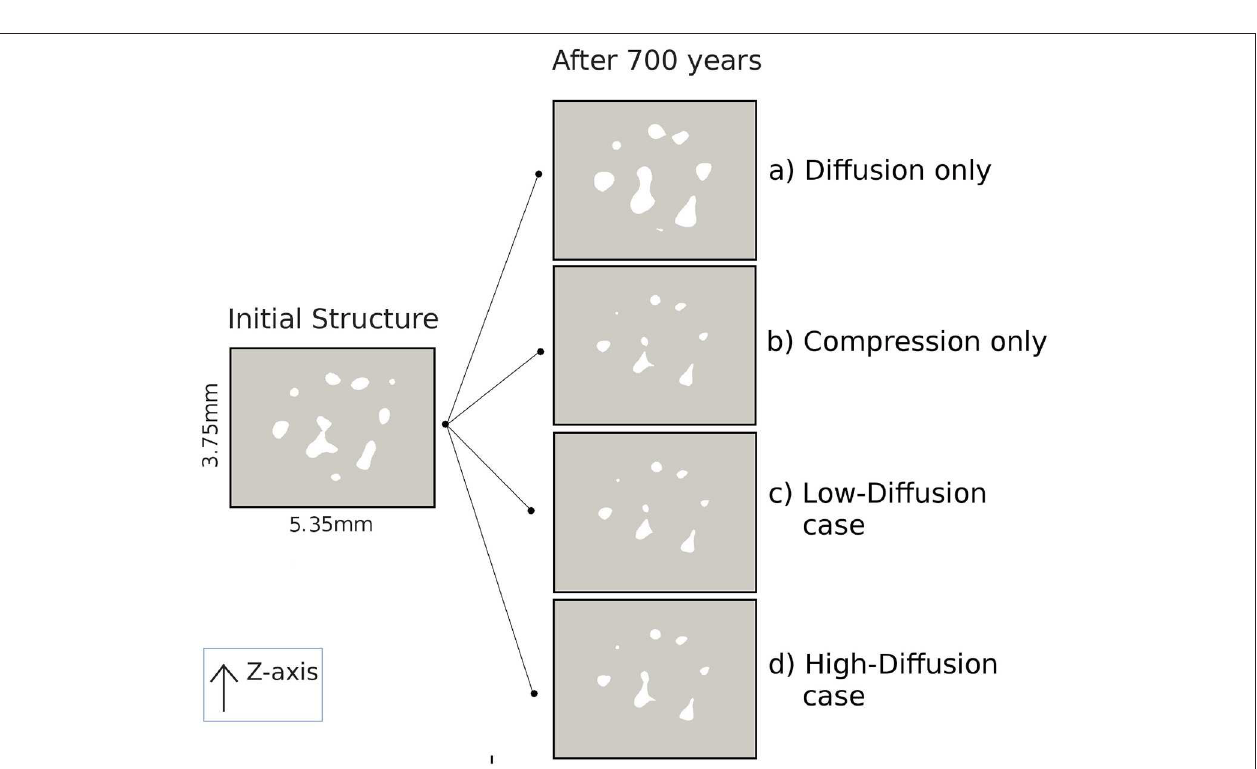
FIGURE 9 | 2D cut-views of the firn material. The gray medium is the ice matrix, and the white spaces are the pores. The slice on the left shows the initial porous structure used in all the simulations, and the four slices on the right show the results of the four different simulations after 700 years. (A) Diffusion only, (B) compression only, (C) Low-diffusion case, (D) High-diffusion